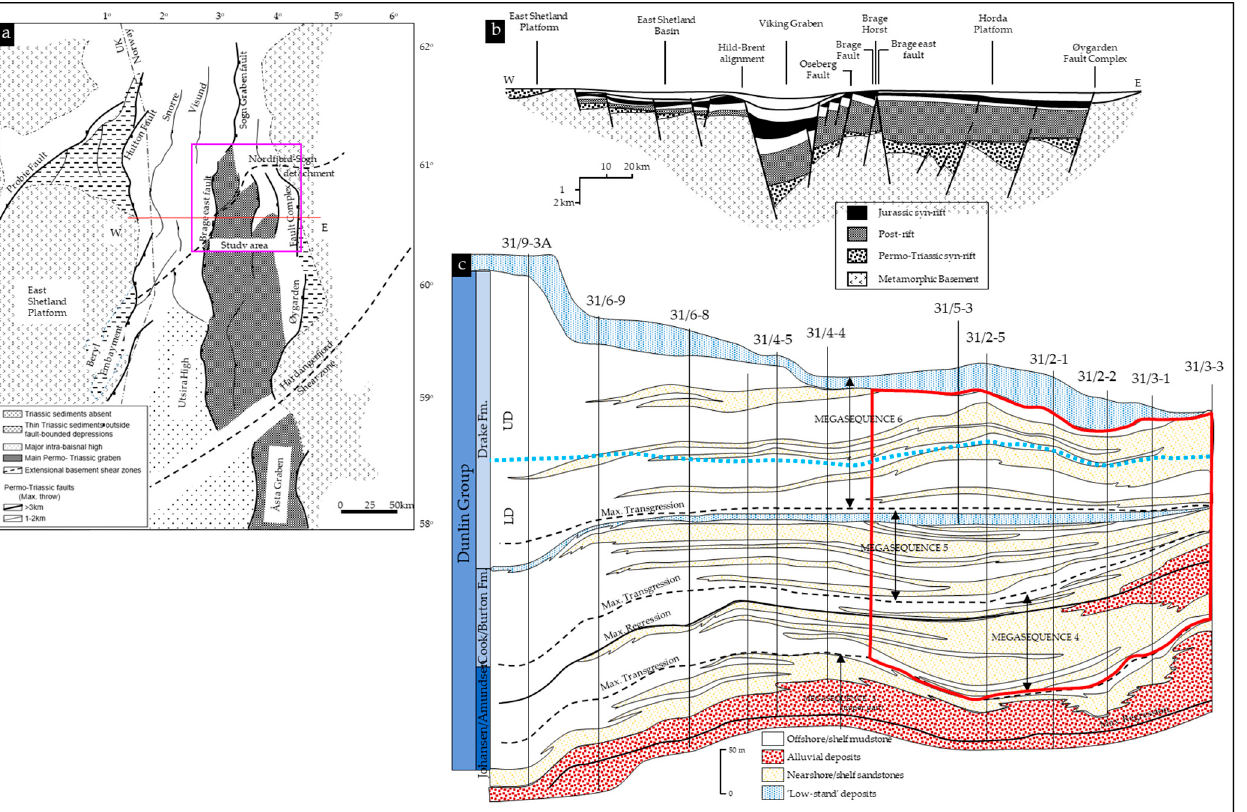
Figure 2. ( a ) Main structural elements of the northern North Sea, resulting from Permo–Triassic extension, reveal the major faults and Nordfjord–Sogn detachment (modified after Færseth, [10]). Violet rectangle within the figure a represents the study area covered in this research ( b ) An E–W cross-section through the northern North Sea (marked in ( a )) shows the sedimentation and major faults during syn- and post-rift times (modified after Færseth, [10]). ( c ) Schematic representation of Triassic and Jurassic post-rift mega-sequences (modified after Steel, [11]). The Horda Platform area is marked in the red rectangle.